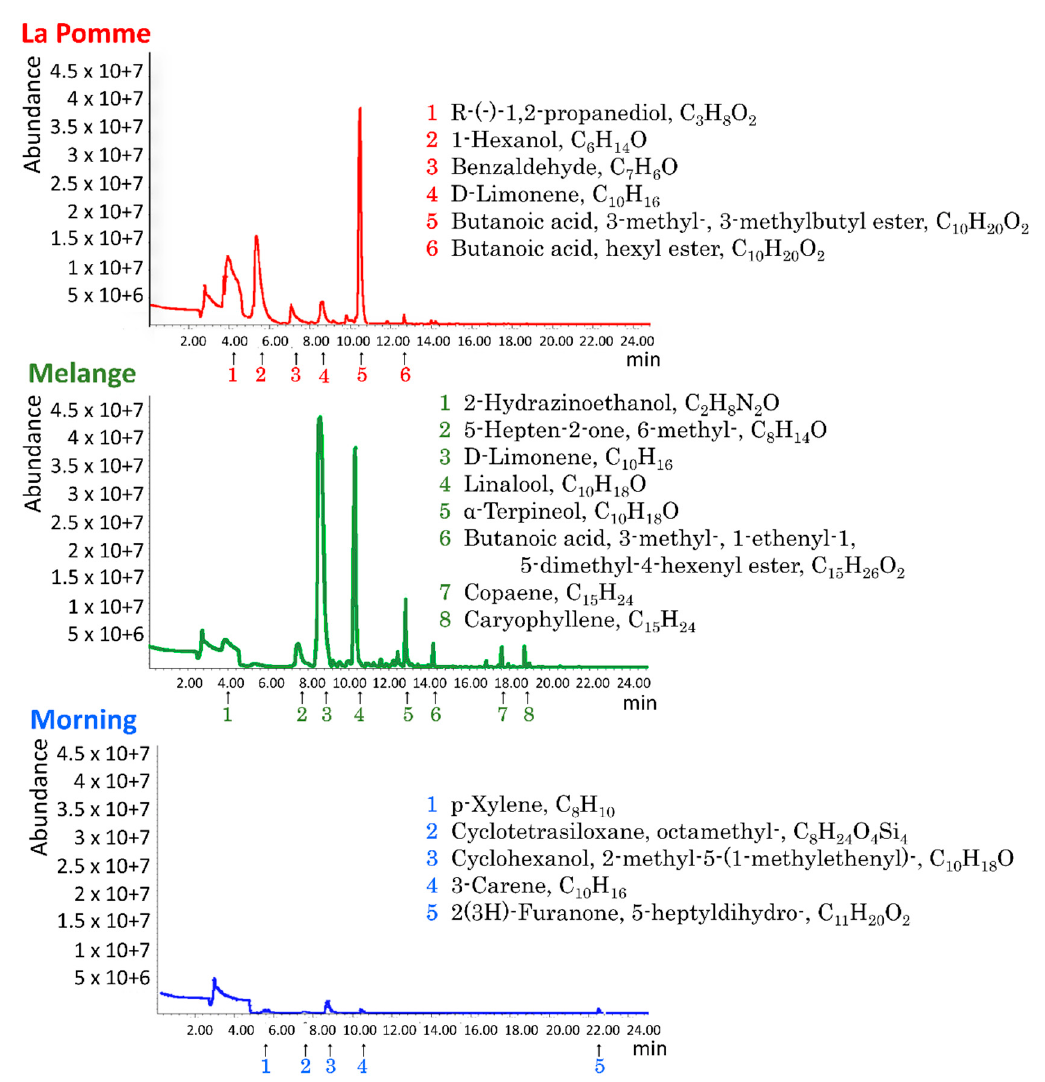
Figure 5 . Chromatograms of the fragrances emitted from each herbal tea by GC-MS measurement. The main components are indicated in the figure.